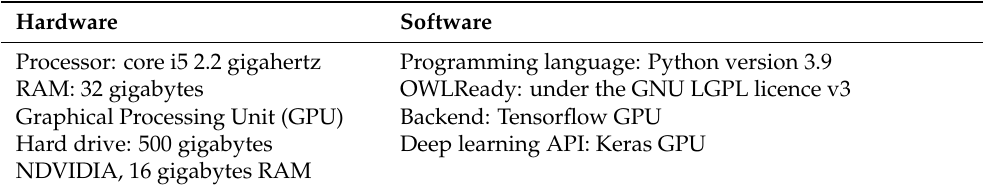
Table 4. Hardware and software specifications for the